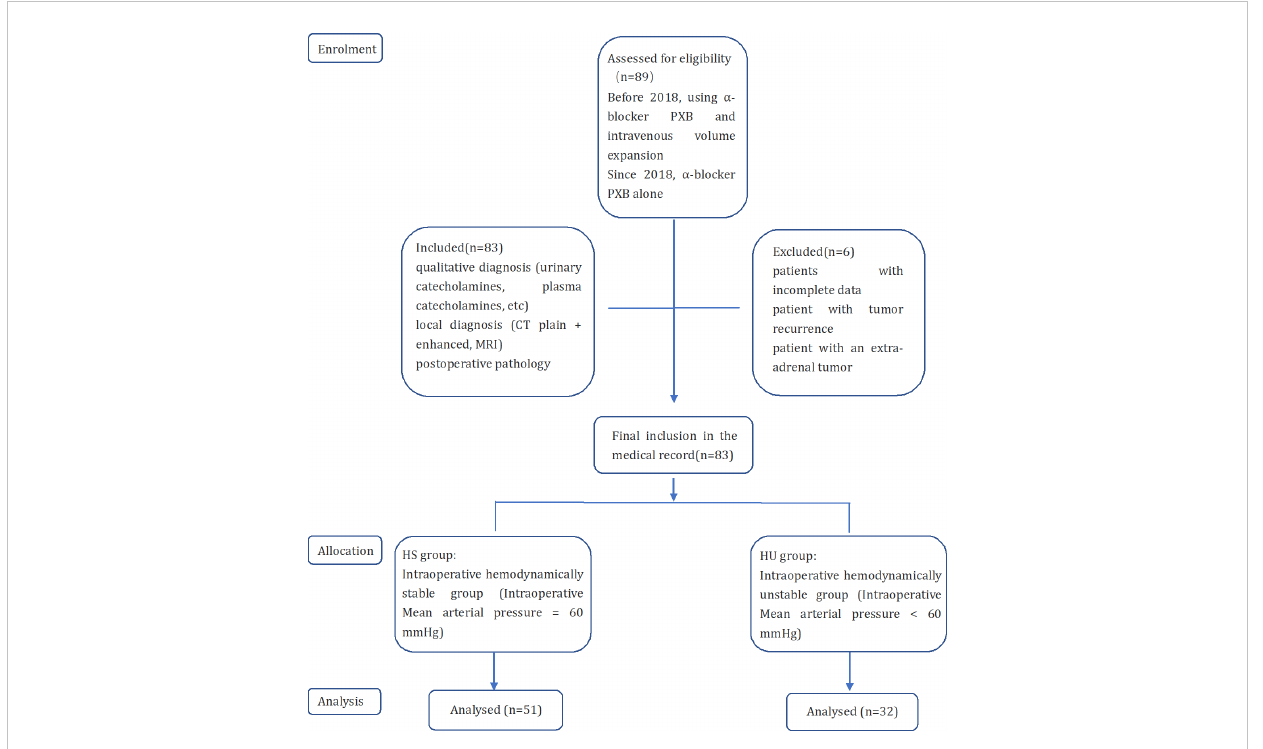
FIGURE 1 Flow chart of the study grouped according to hemodynamic stability or